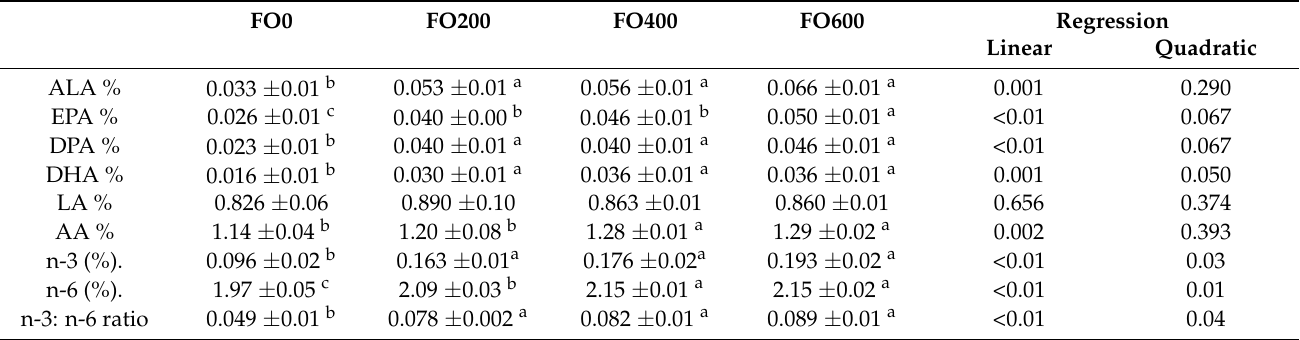
Table 5. Effect of FO Supplementation on the Fatty Acid Composition of Breast Muscle.